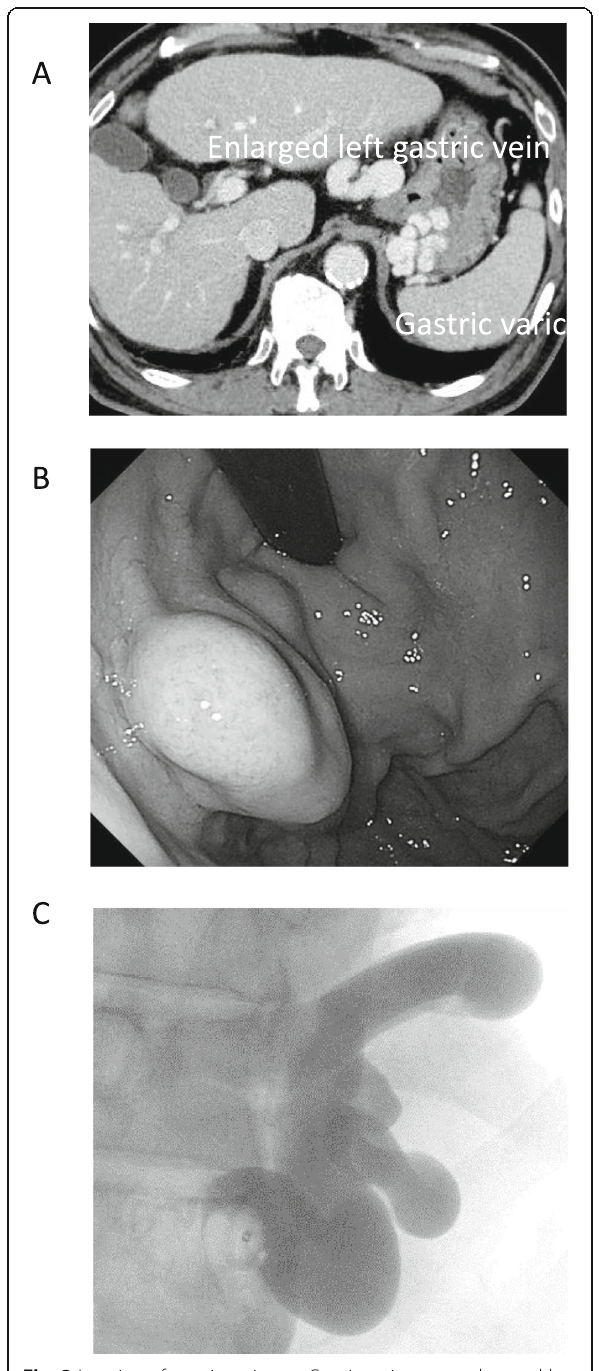
Fig. 3 Imaging of gastric varices. a Gastric varices were detected by CT as an enlarged gastrorenal shunt from the left renal vein to the left gastric vein. b Gastric varices developed into enlarged nodules shown by upper esophagogastroduodenoscopy. CT, computed tomography